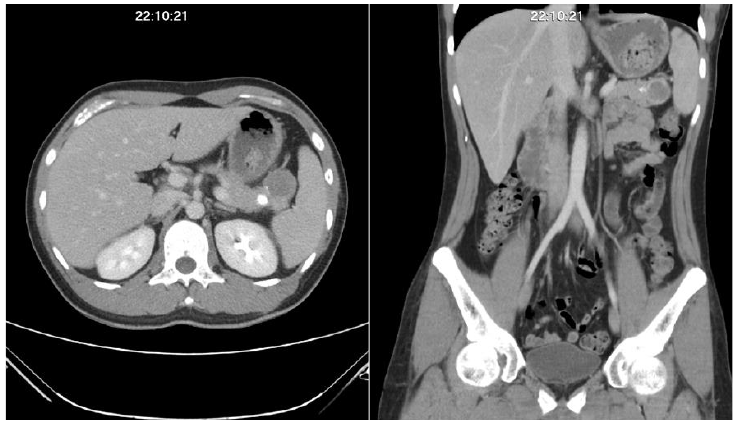
Figure 1. Abdominal computerized tomography scan result. The patient had a poorly enhanced mass lesion with calcification over the pancreatic tail region found during the follow-up computerized tomography scan one year after the initial diagnosis.